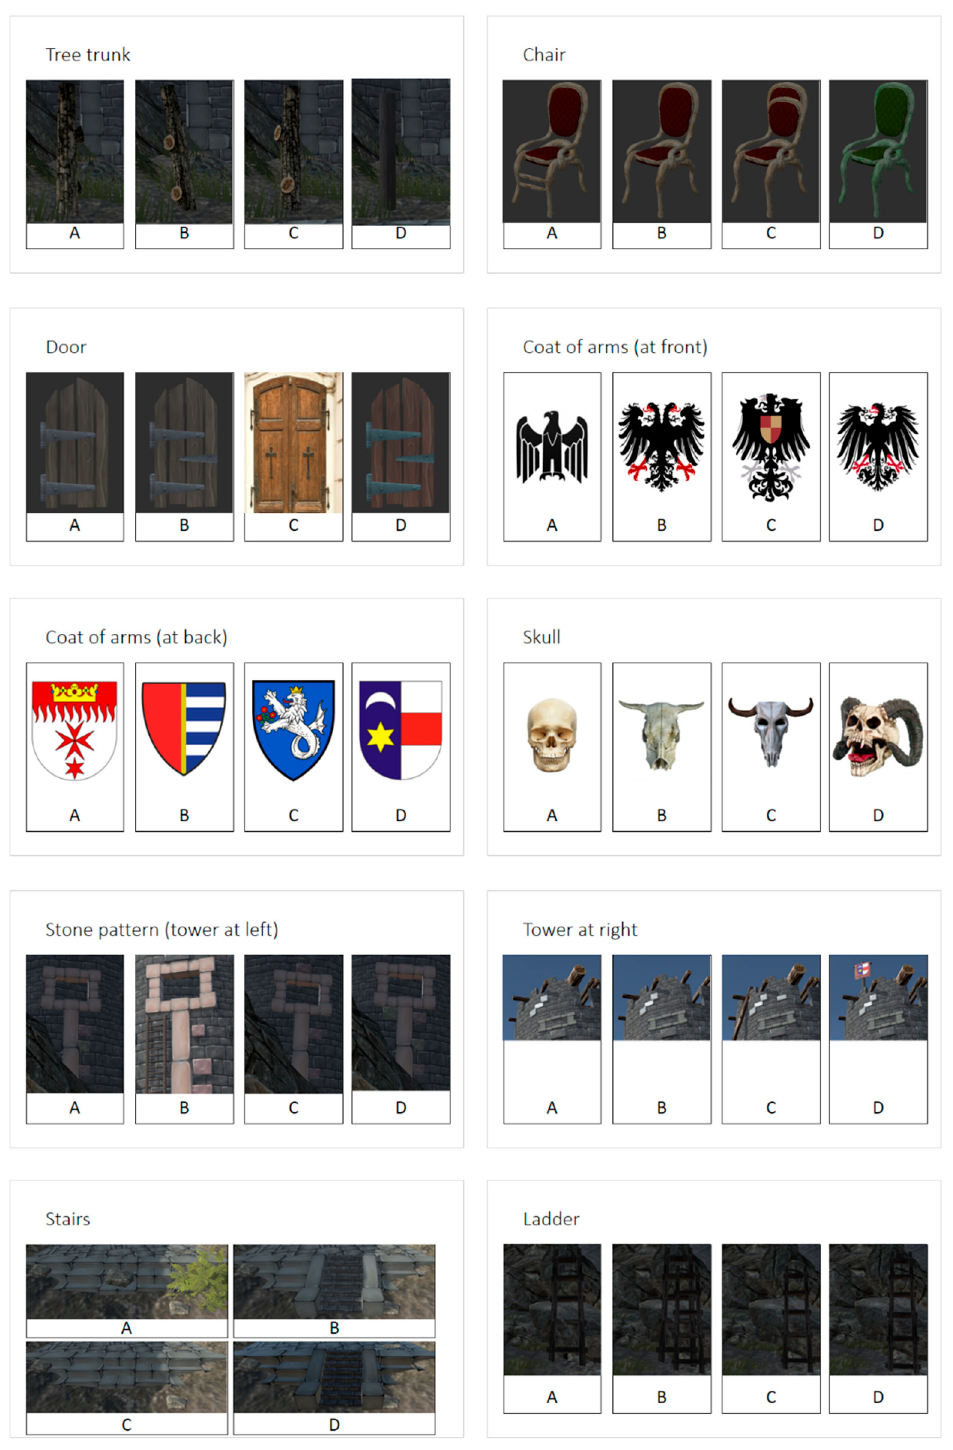
Figure A1. The ten sets of items for the Object Visual Recognition Test.